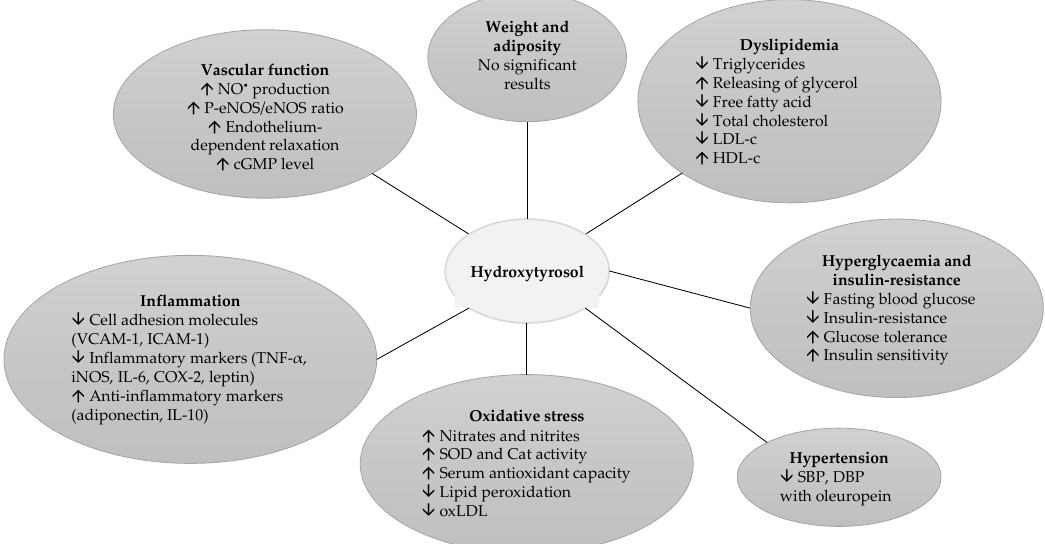
Figure 1. Effect of hydroxytyrosol on metabolic syndrome-associated complications and metabolic syndrome. ↑ : Increase in; ↓ : Decrease in. LDL-c: Low-Density Lipoprotein-cholesterol; HDL-c: High Density Lipoprotein-cholesterol; SBP: Systolic Blood Pressure; DBP: Diastolic Blood Pressure; SOD: Super Oxide Dismutase; Cat: Catalase; oxLDL: oxidized Low-Density Lipoprotein; VCAM-1: Vascular Cell Adhesion Molecule-1; ICAM-1: Intercellular Adhesion Molecule-1; TNF- α : Tumor Necrosis Factor alpha; iNOS: inducible Nitric Oxide Synthase; IL-6: Interleukin-6; COX-2: Cyclooxygenase-2; IL-10: Interleukin-10; NO • : Nitric Oxide; P-eNOS/eNOS: Phosphorylated Endothelial Nitric